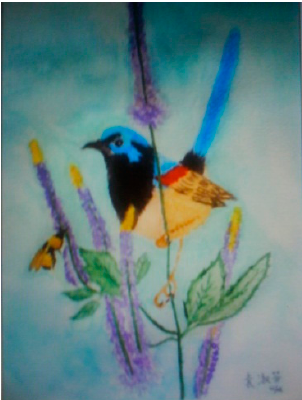
Figure 6. Learning about new abilities: painting.